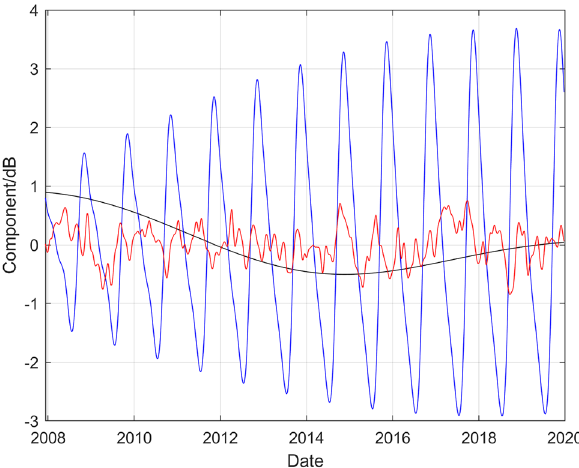
Figure 6. Comparison of the long-term, medium-term seasonal, and short-term components extracted from the results of the GP regression shown in Fig. 2. The black curve denotes the long-term component, the blue curve the medium-term seasonal component and the red curve the short-term component, respectively.